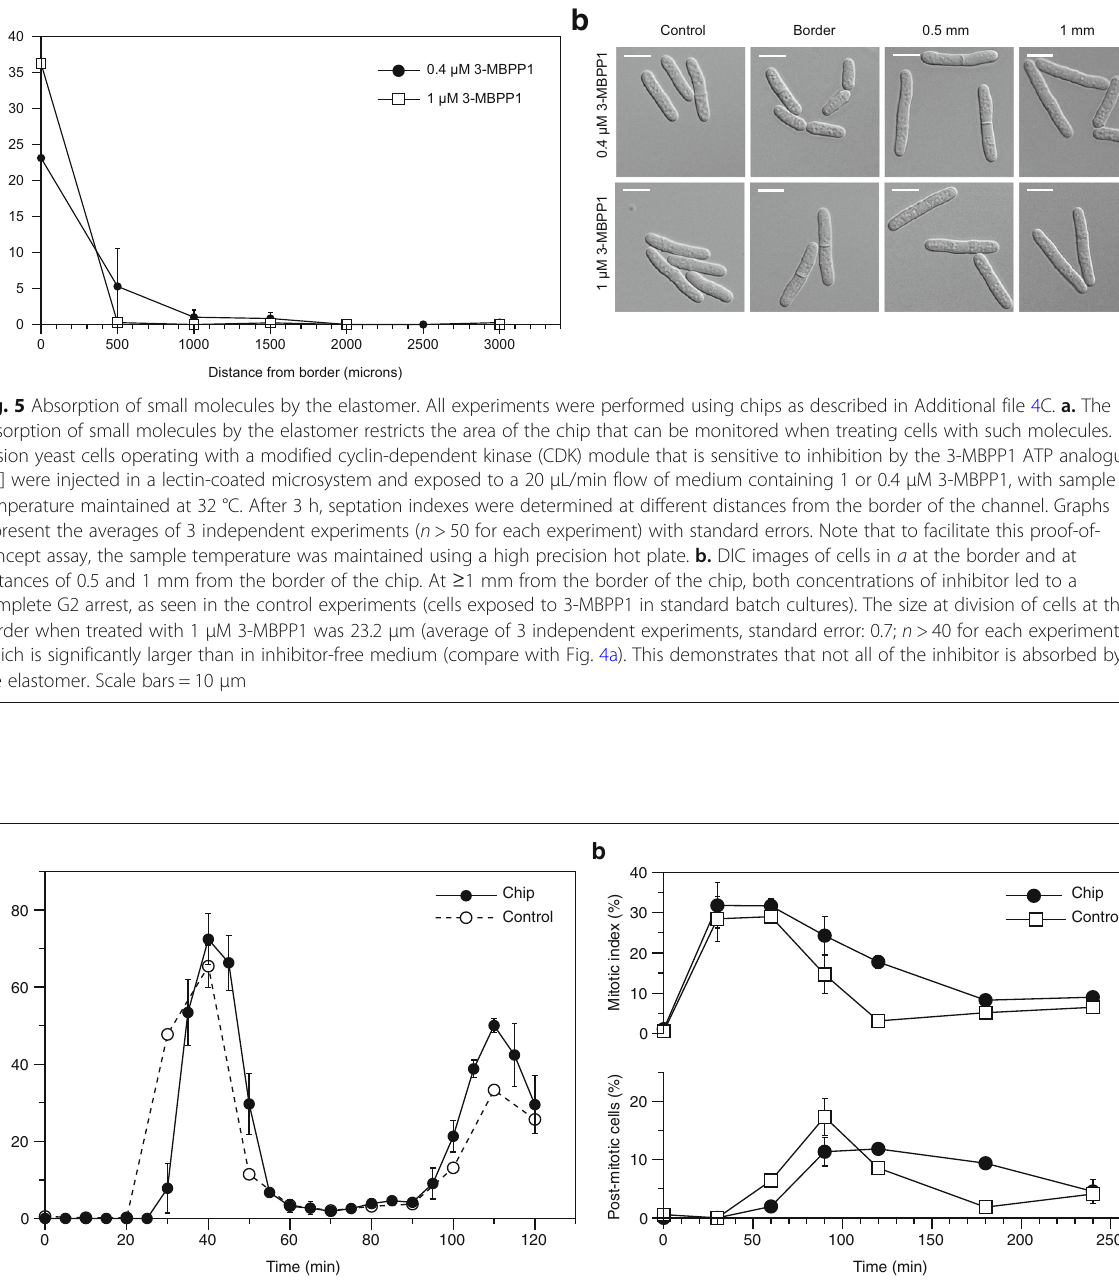
Fig. 6 Monitoring cellular responses to dynamic changes in their environment. a . Analogue-sensitive fission yeast cells [37] were injected in a lectin- coated chip (as in Additional file 4C) and perfused with 1 μ M 3-MBPP1 (20 μ L/min) at 32 °C for 2 h 45 min (G2 block) before being released in inhibitor-free medium (T=0, 20 μ L/min). Control: cells grown in batch cultures at 32 °C, treated with 1 μ M 3-MBPP1 for 2 h 45 min and released into inhibitor-free medium by filtration (T=0). The septation indexes were then monitored over time (n>50 for each time point). Averages of 3 independent experiments are shown with standard errors. Note that images were acquired every 5 min for the chips (mounted on a microscope) but every 10 min for the flasks, for which 5 min intervals were difficult to achieve. This led to a higher variability in timing for the chip assays compared to the less resolved batch cultures. b. HeLa cells were injected in a microsystem (as in Fig. 4c) maintained at 37 °C on a high precision hot plate to facilitate this proof-of-concept assay. Cells were then allowed to adhere for 3 h and subsequently treated with 6 μ M of the CDK inhibitor RO-3306 for 10 min (13 μ L/min) every hour for a total of 20 h. Cells were subsequently released in inhibitor-free medium (T=0; 15 min at 20 μ L/min and then 5 μ L/min), and the percentages of mitotic (rounded) and post-mitotic (doublets) cells were quantified over time. Measurements were made in an area within 1.5 mm on each side of the center of the channel. As a control, cells treated with 6 μ M RO-3306 in dishes were washed and incubated in normal medium. Averages of 3 independent experiments ( n >100 for each experiment) are shown with standard